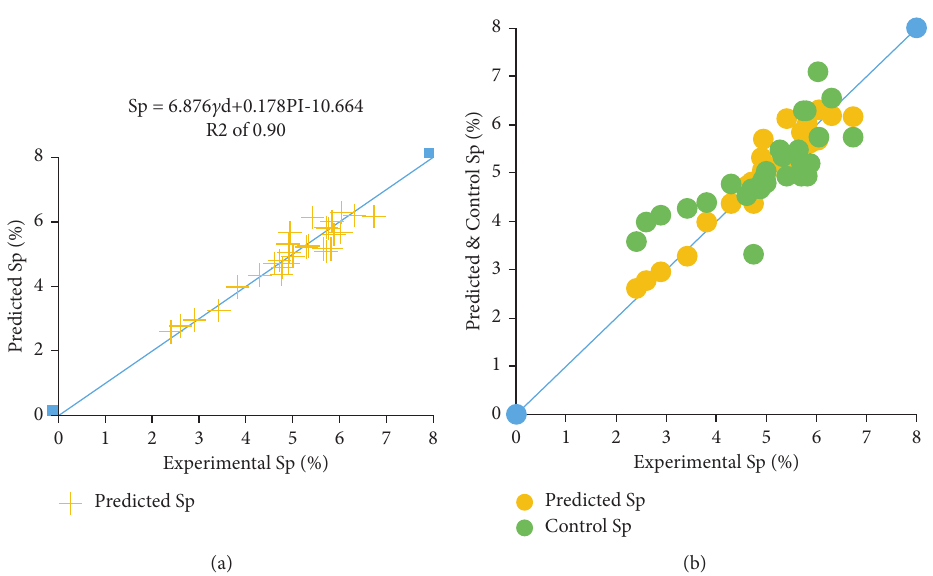
Figure 5: (a) Relationships between experimental and predicted, (b) variations between control and predicted swelling